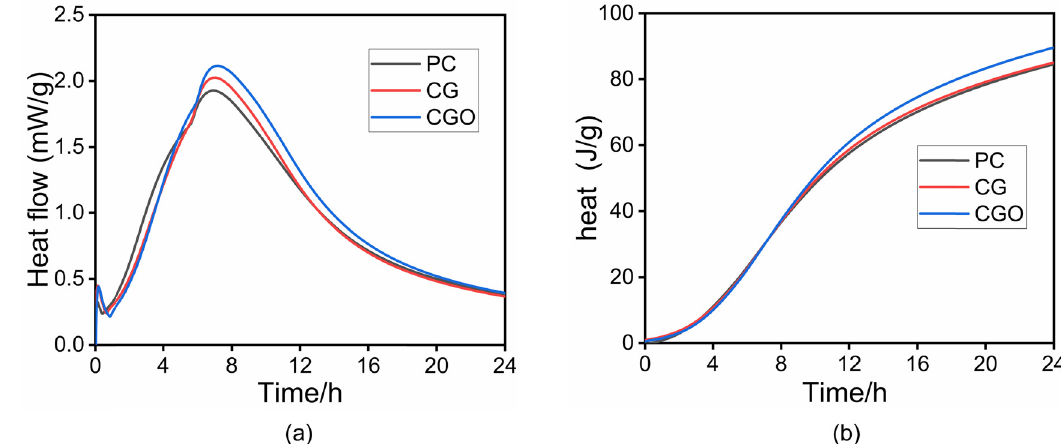
Figure 8: The heat fl ow ( a ) and accumulated heat ( b ) of PC, CG, and CGO pastes.